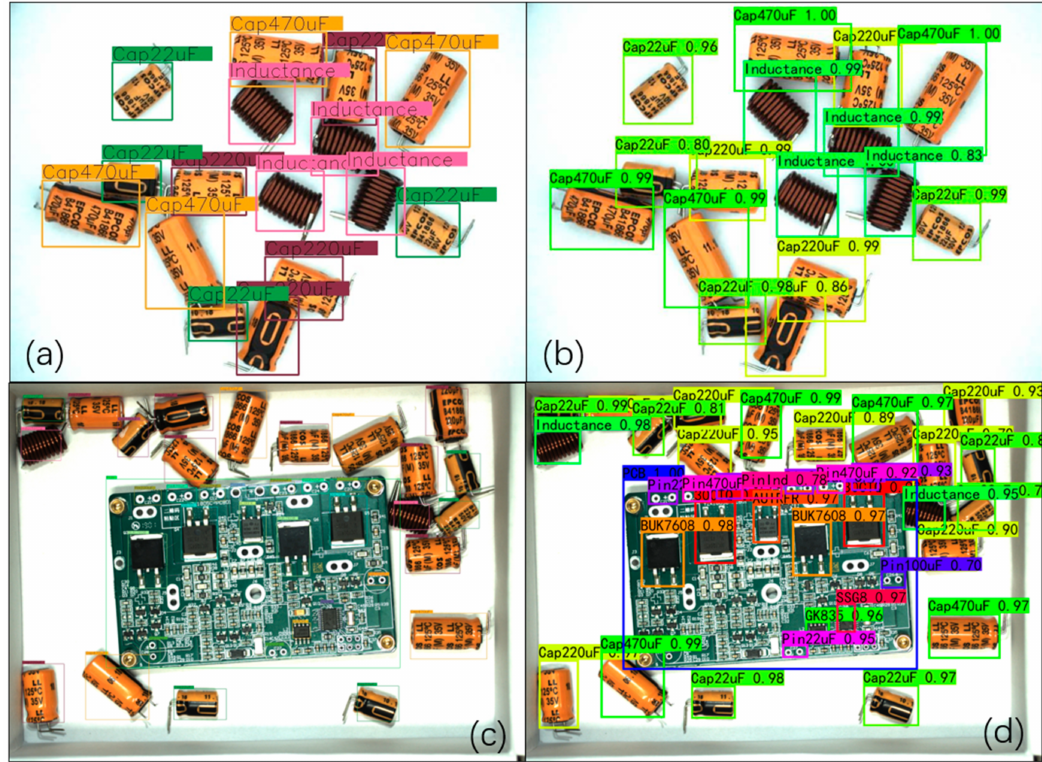
Figure 13. Object detection result before PCB assembly based on Balanced-YOLOv3 ( a ) Ground truth of disordered electronic components before assembly ( b ) Object detection result of disor- dered electronic components before assembly ( c ) Ground truth of original image1 before assembly ( d ) Object detection result of original image1 before